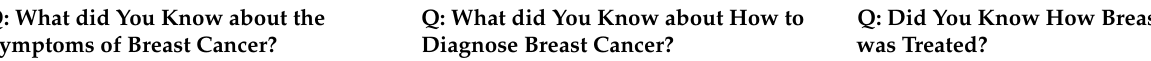
Table 2. Breast cancer previous